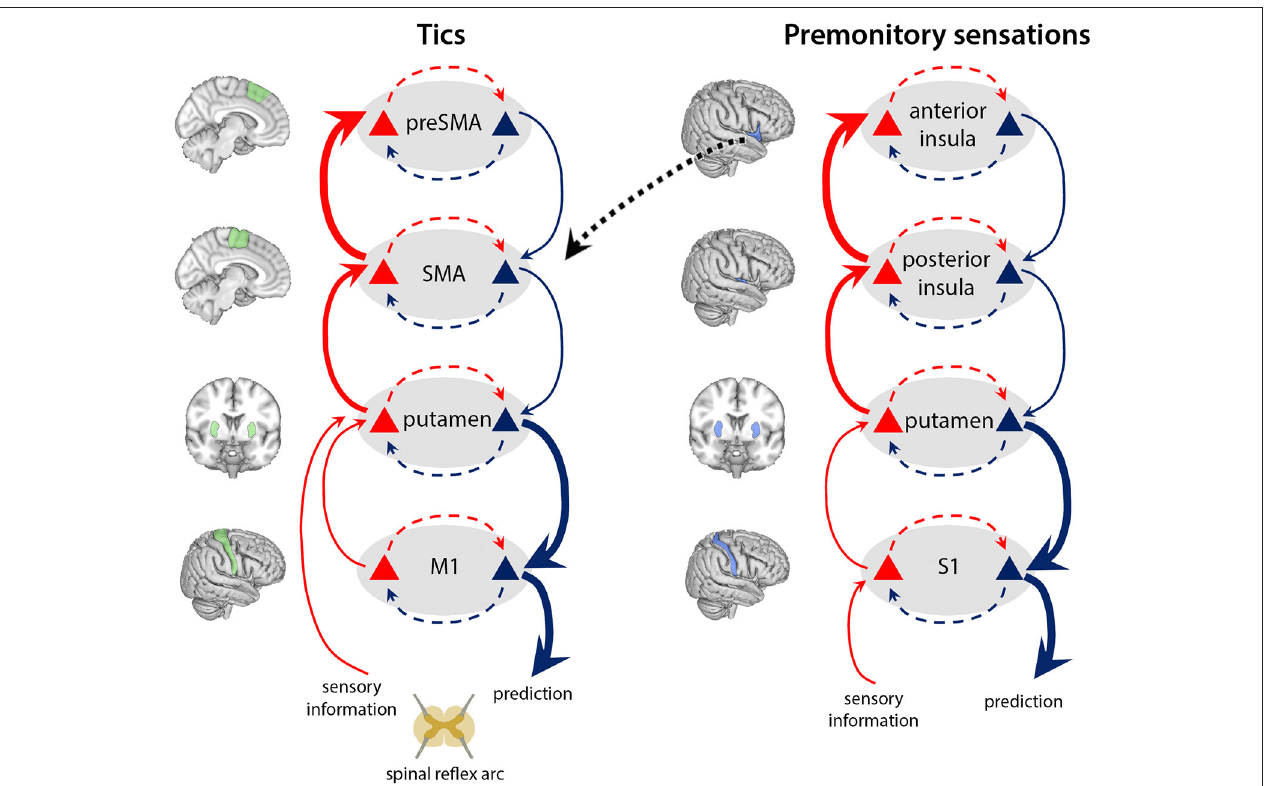
FIGURE 3 | Tics and premonitory sensations arise through overly precise priors for action and sensation within the putamen. In our model of TS, increased cortical signalling from the SMA, combined with reduced regulation by inhibitory interneurons in the putamen (see Figure 4 ), leads to release of signals for movement to M1 with enhanced precision. These precise priors (blue) generate tics, leading to ascending prediction error signals from putamen (bold red arrows) indicating production of an action that was not predicted within high-level regions, and which is “explained away” by the preSMA ascribing an “unvoluntary” feeling to the action—that it was “somewhat intended.” Similarly, increased cortical signalling from the posterior insula, combined with reduced regulation by inhibitory interneurons in the putamen, leads to signals passing to S1 with enhanced precision. These precise priors (blue) generate bodily sensations, leading to ascending prediction error signals from putamen to anterior insula (bold red arrows) for bodily feelings that were not predicted within this higher level region, which are therefore “explained away” by the anterior insula as unexpected or “untoward” bodily feelings that require mitigating action to remove. To do so, anterior insula sends signals to midline motor regions such as the SMA (dotted black arrow): augmenting the excitatory inputs from SMA to motor putamen, further ramping up the process of tic generation. Within-layer interactions (dashed red and blue arrows) represent canonical microcircuits ( 88) in which superficial pyramidal neurons (red triangles) compare expectations with predictions from deep pyramidal neurons (blue): discrepancies at the highest hierarchical levels are explained away as “unvoluntary” actions (tics), and untoward bodily feelings (premonitory